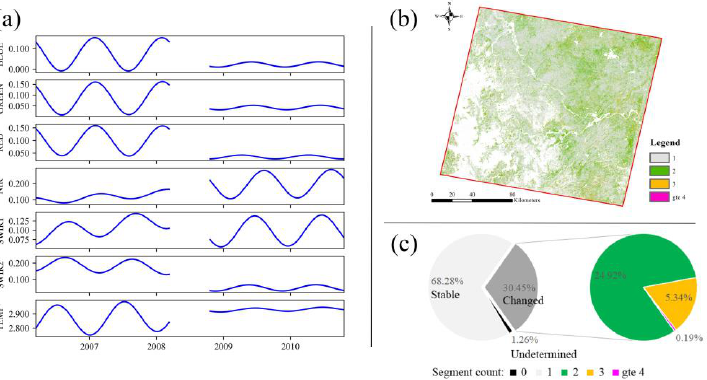
Figure 6. In order from ( a – f ) are Cropland_Potapov, Cropland_FROMGLC10, Cropland_Terrace, Cropland_GlobeLand30, Cropland_GLC_FCS30, and Cropland_CLCD. They are sorted in ascend- ing order by cropland area, as shown in the horizontal bar chart. For aesthetic purposes, the cropland layer in yellow is superimposed on a true colour base map. Panel ( g ) is the potential his- torical cropland extent as the union of these six cropland layers. Panel ( h ) is the mask of built-up areas (in red) and water bodies (in blue). Panel ( i ) is the masked cropland with built-up areas and water excluded. Panel ( j ) shows the count of cropland flags from these six cropland layers over the red square region in panel ( i ).